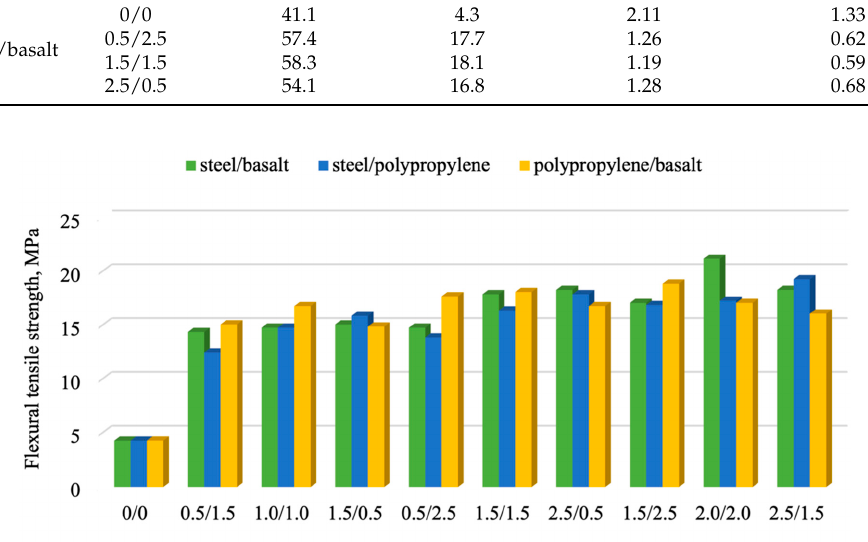
Figure 8. Dependence of the tensile strength in the bending of fiber-reinforced concrete on the type of fiber combination and volume content.